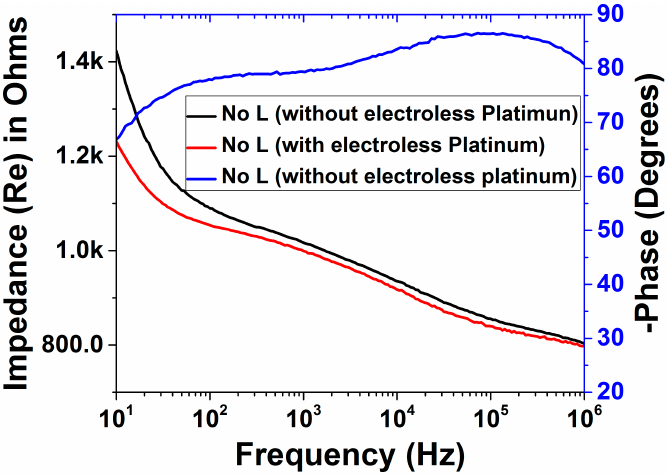
Figure 12. ( a ) Full spectrum impedance and ( b ) phase response of the three distinct types of microelectrodes (average of n = 9 of each electrode type) prior to the electroless plating step. ( c ) Average impedance ( n = 9) of the electrodes after electroless platinum plating for 6 h. Scan rate variation of cyclic voltammetry for the SU-8 cast/crosslinked and laser micromachined electrode (30 μm × 30 μm in size) ( d ) before and ( e ) after electroless plating. ( f ) Current-scan rate plot of the SU-8 cast/crosslinked and laser micromachined electrodes before and after electroless plating with linear fit. Micromachines 2018 , 9 , 85 17 of 24